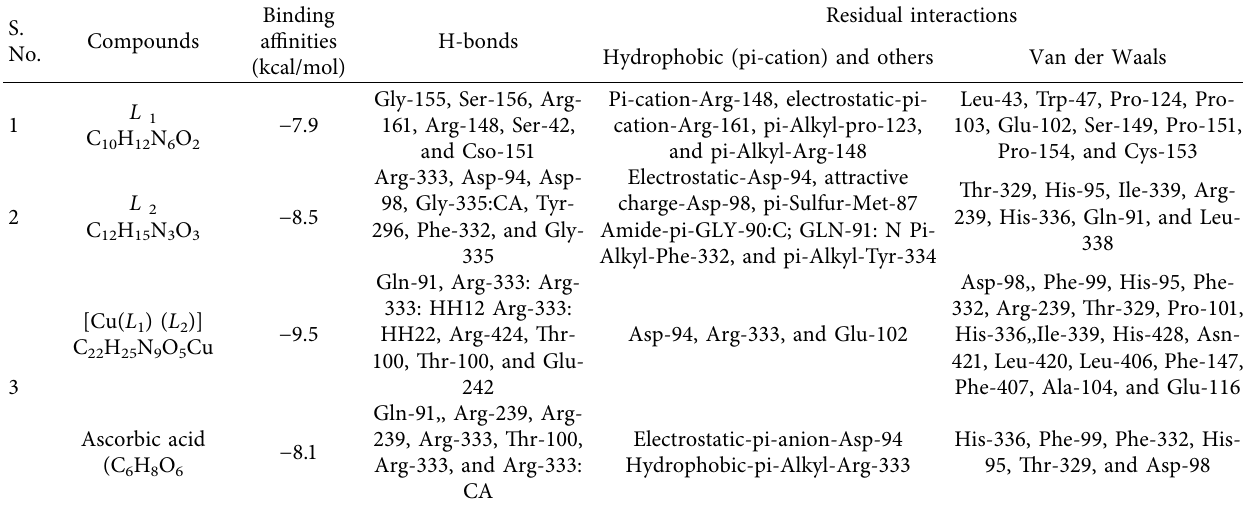
Table 5: docking result of the sample on human myeloperoxidase.